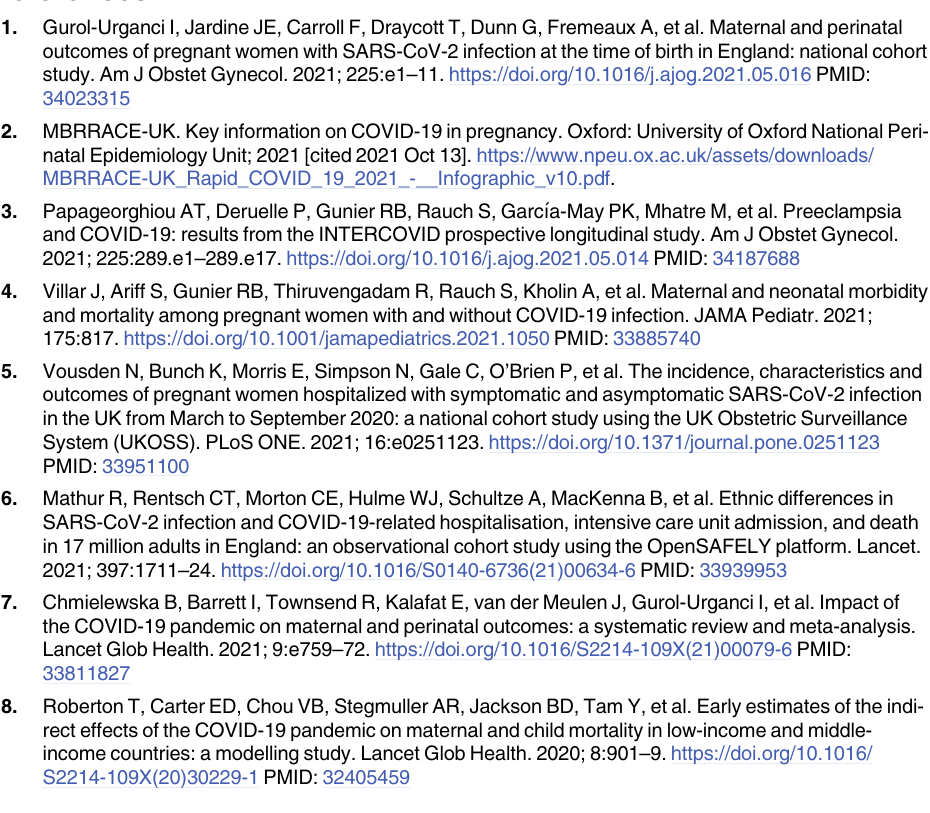
S4 Table. Comparisons of outcomes in the COVID-19 pandemic with outcomes in the same period in the previous year, by